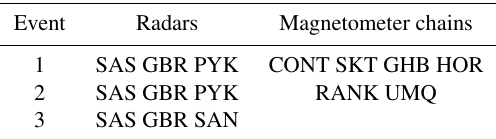
Table 2. See Fig. 1 for map and key to station